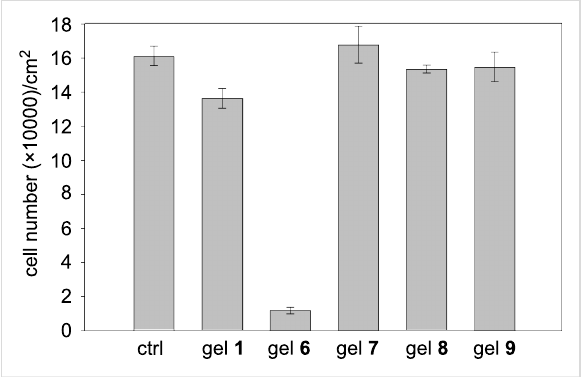
Figure 5: IGROV1 cell growth after 24 hour treatment with hydrogels 1, 6–9 .